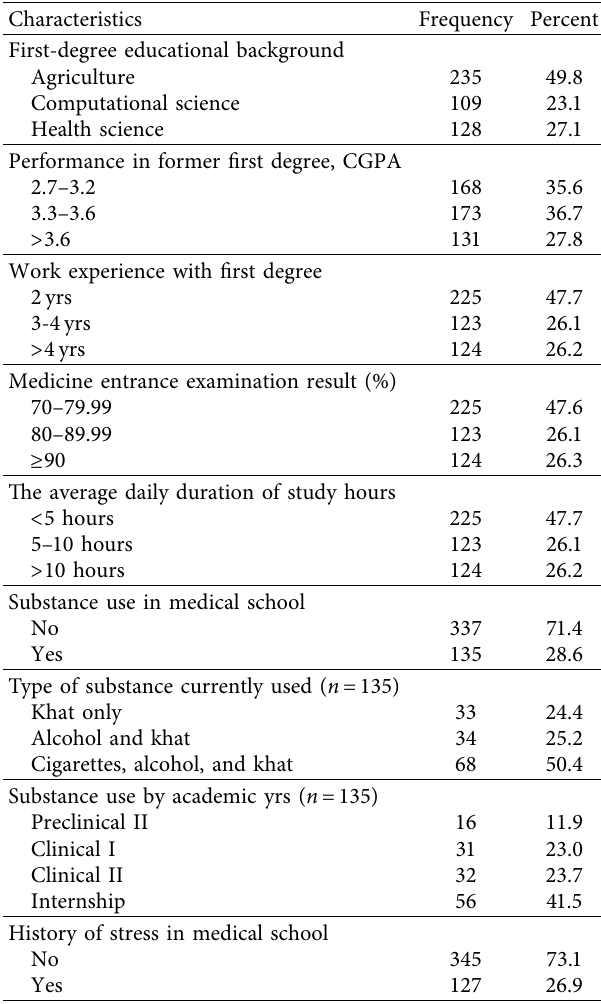
Table 2: Former first-degree educational background and be- havioral characteristics of new medical education system students in